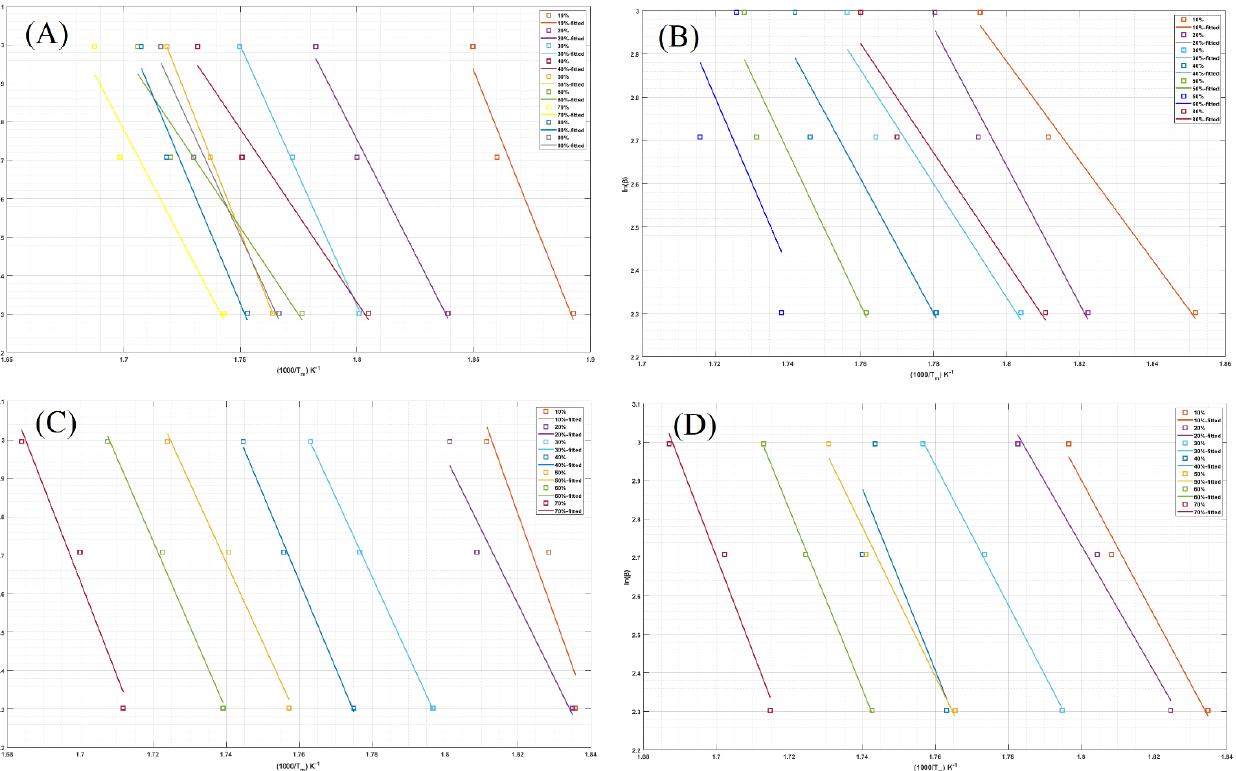
Figure 7. Ozawa – Flynn – Wall (OFW) drawing for ( A ) LPS, ( B ) LPS/CNPs 1%, ( C ) LPS/CNPs 3%, and ( D ) LPS/CNPs 5%.